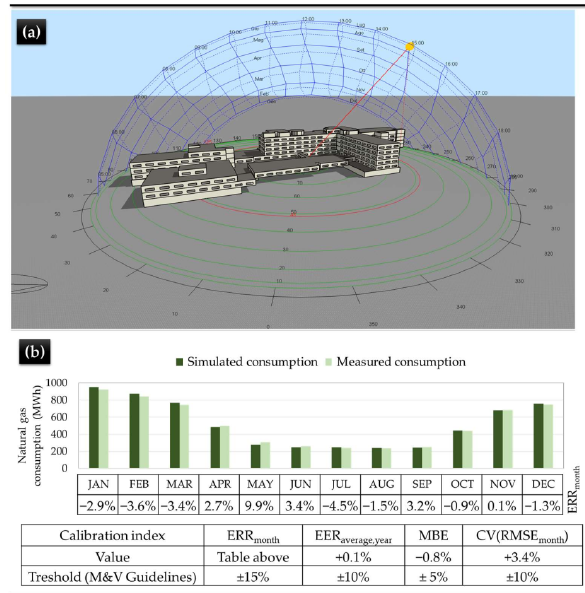
Figure 2. Numerical model developed ( a ); comparison between monthly real consumptions and energy simulation results ( b